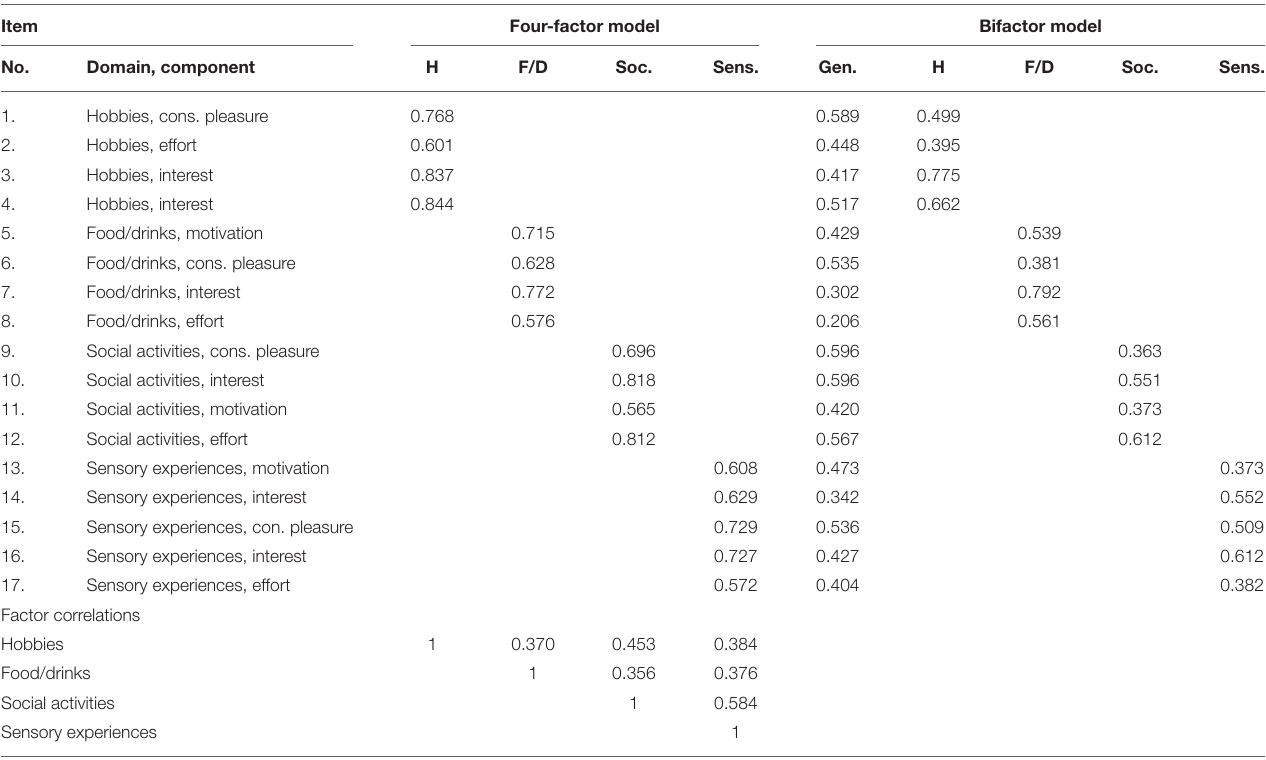
TABLE 2 | CFA standardized factor loadings and between factor correlations. Item